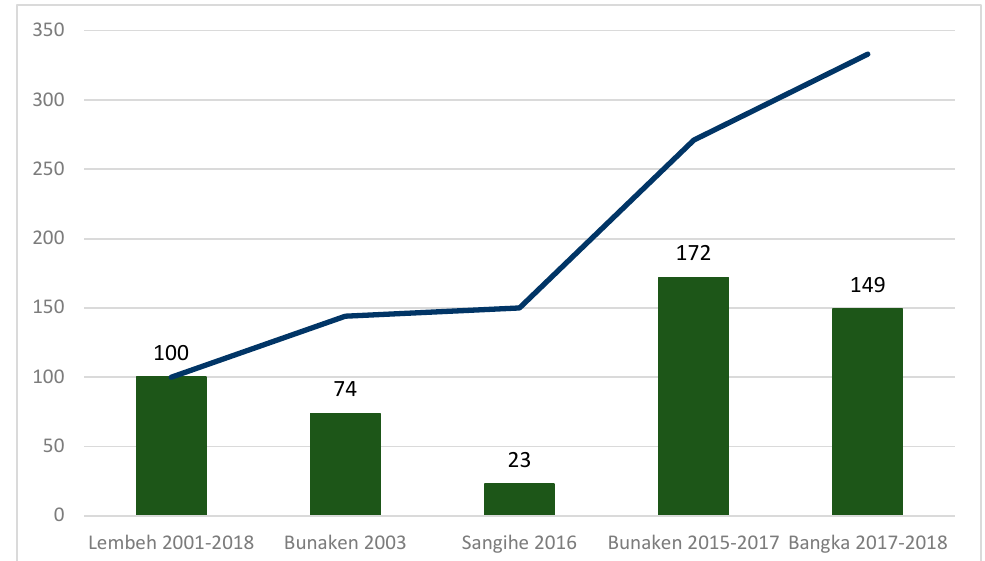
Figure 25. Species accumulation curve (black line) and number of species per locality (red bars). Numbers in brackets after the locality name indicate the number of sampling events at that particular site. Note the high number of sampling events at the locality Coral Eye.